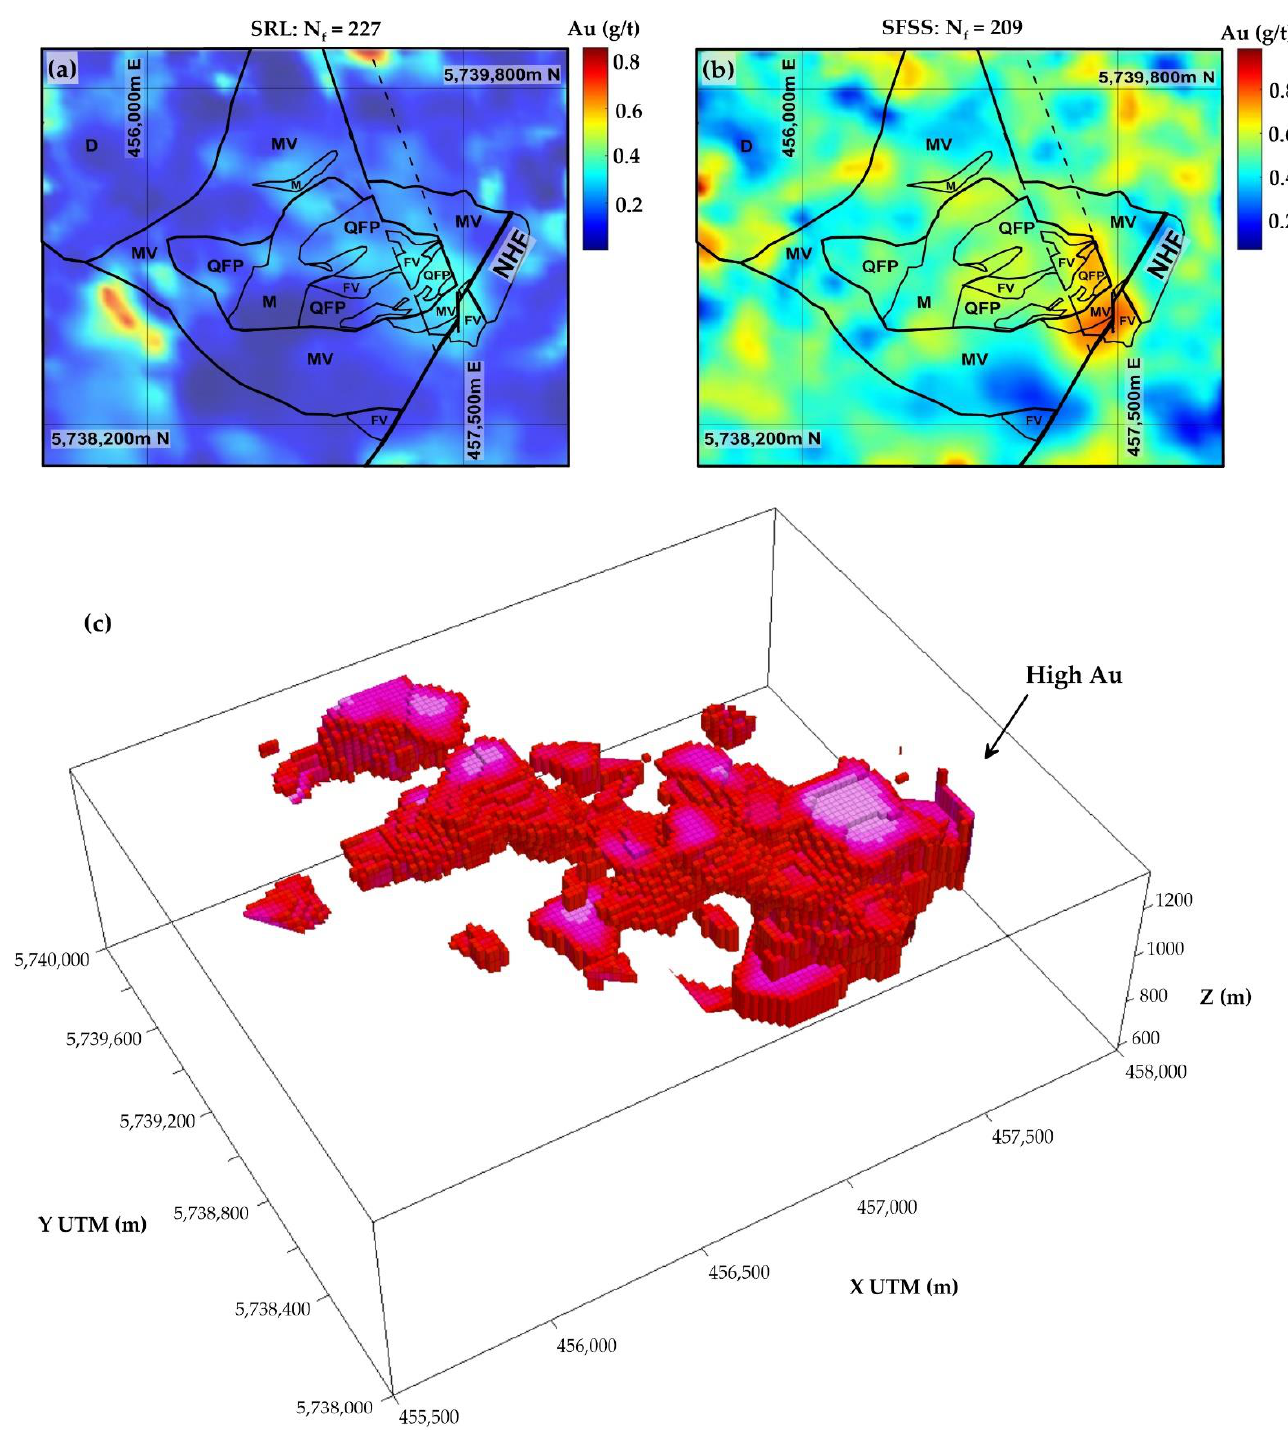
Figure 12. Au grade predictions: Results of 3D SRL predictions ( a ) versus 3D SFSS predictions ( b , c ). SFSS resulted in the better reconstruction of Au-grade distributions with a smaller number of input spectral features ( N f ). Results are sliced horizontally at the elevation of 1000 m.